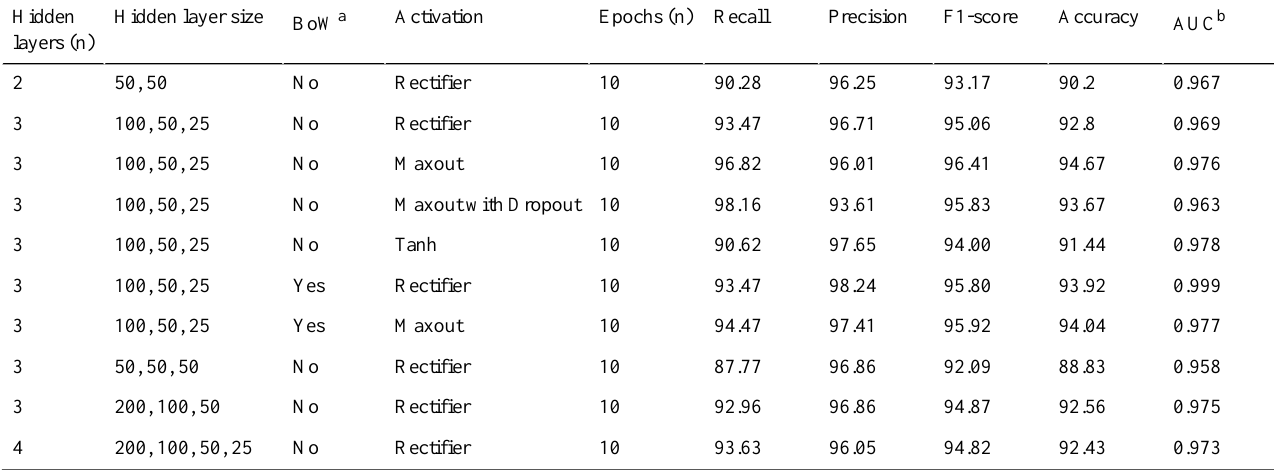
Table 5. Results of multilayer perceptron with varied hyperparameter settings.